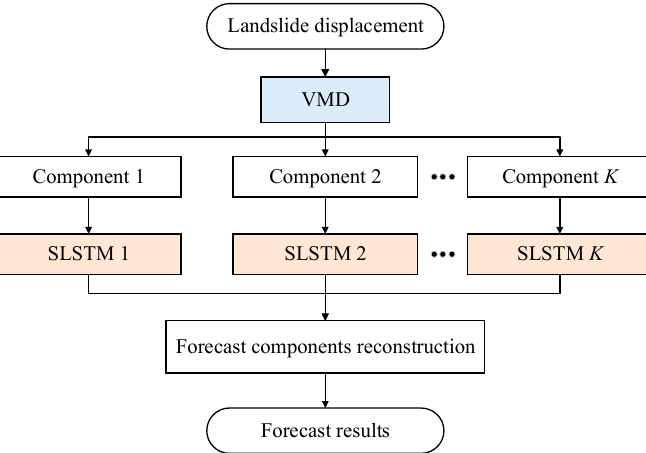
Figure 3. Landslide displacement forecasting flow chart based on the variational mode decomposition (VMD)-SLSTM network.